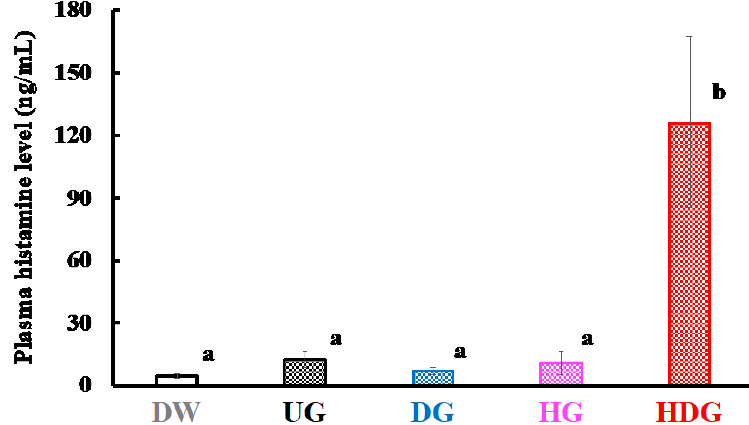
Figure 6. Plasma histamine levels of mice after intraperitoneal challenge of gliadin followed by cutaneous sensitization with the corresponding gliadin. Values with different letters are significantly different at p < 0.05 based on the Tukey–Kramer test. Each value is the mean of eight experiments with SE shown as a vertical bar.